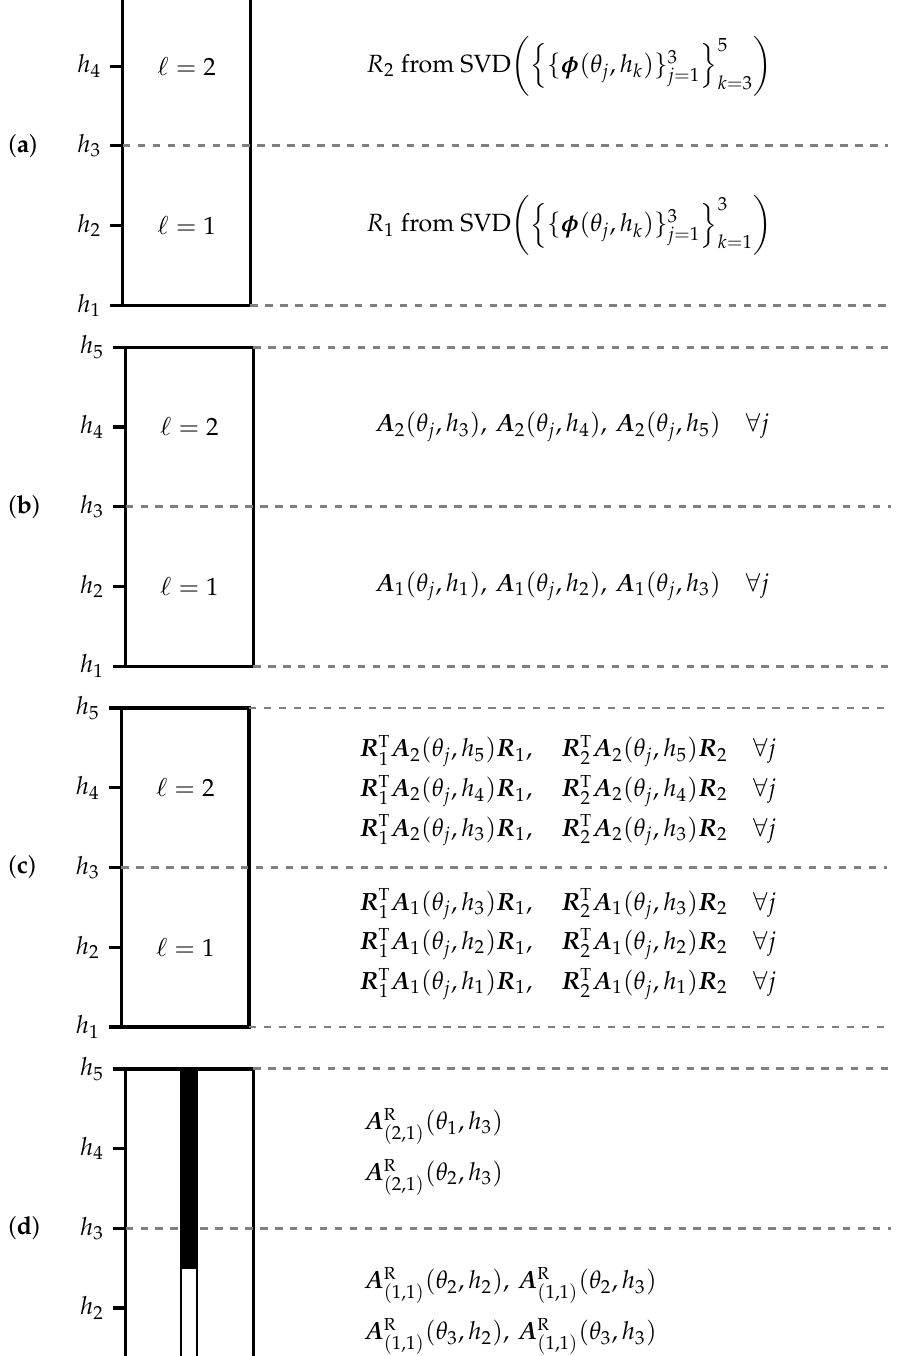
Figure 1. Suppose snapshots are taken at 5 control-rod positions { h k } 5 and the domain has been divided into two layers. The diagrams show ( a ) which snapshots are used to generate the bases at each level, ( b ) which full order matrices are generated, ( c ) which reduced-order matrices are produced by projecting the full order matrices onto the bases, ( d ) which reduced-order matrices are interpolated for an unseen control rod height that lies between h 2 and h 3 in layer 1 and a temperature profile whose average value for layer 1 lies in [ θ 2 , θ 3 ] , and for layer 2, in [ θ 1 , θ 2 ] . For this example, only one control rod is